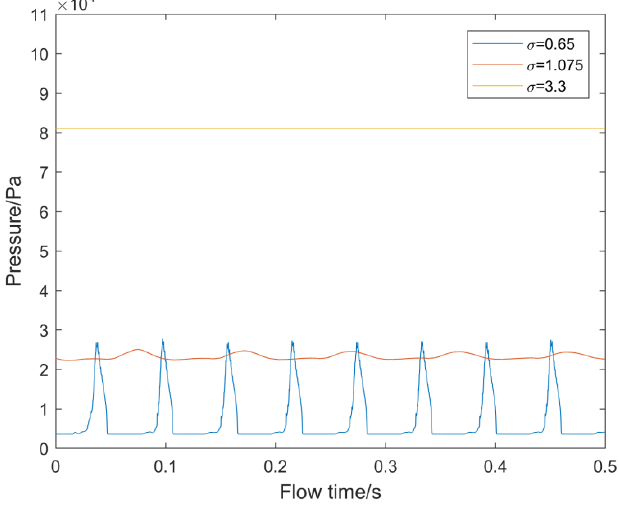
Figure 23. Pressure pulsation at U5 for σ = 0.65, 1.075, and 3.3.